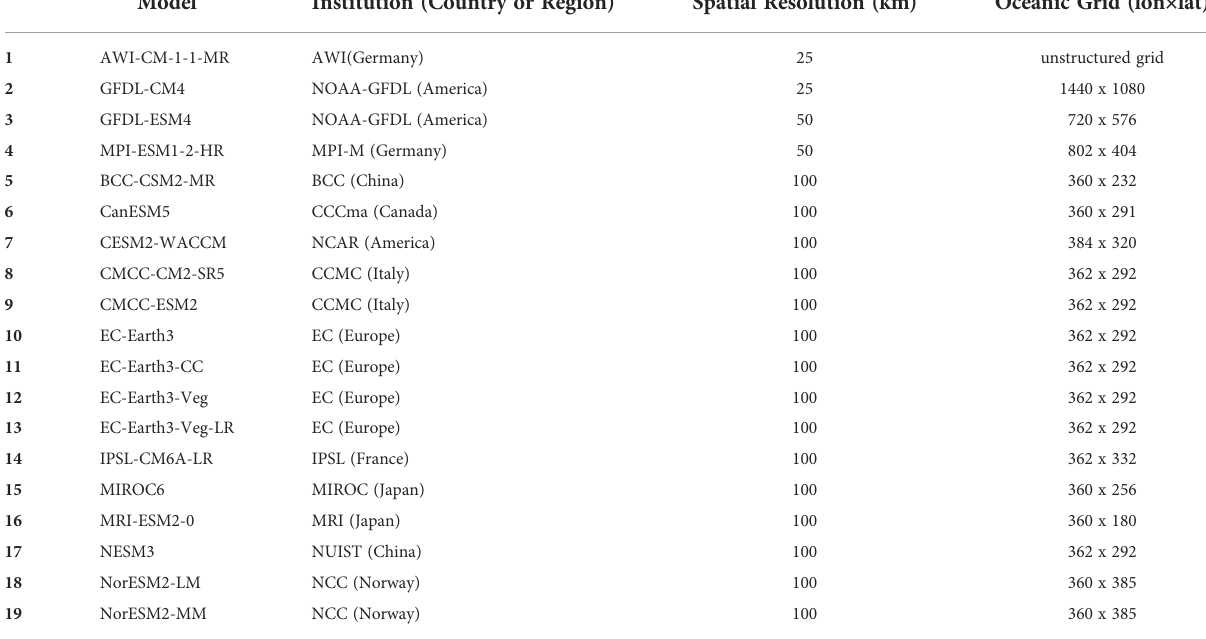
TABLE 1 Basic information of 19 models from CMIP6.